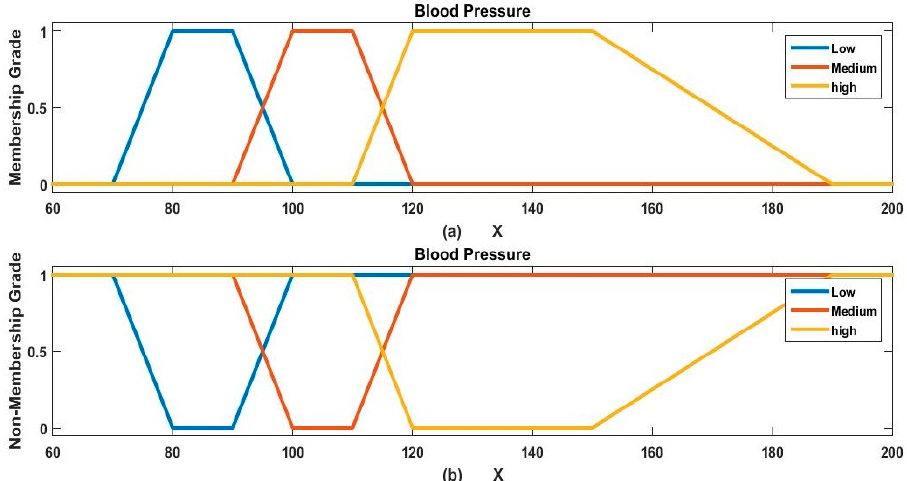
Figure 5. Three linguistic categories of age with their triangular membership ( a ) and non-membership grades ( b ).